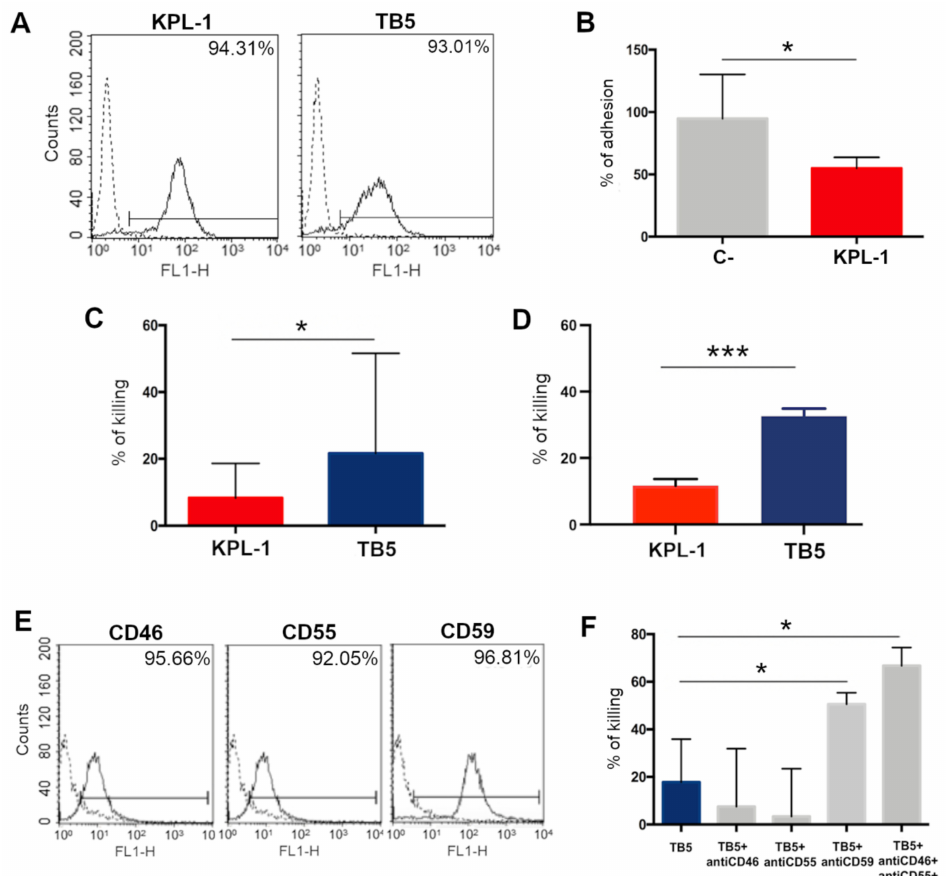
Figure 7. In vitro effect of anti-PSGL-1 antibodies on ALCL cell lines. ( A ) SU-DHL-1, a representative ALCL cell line, was analyzed by flow cytometry using two independent anti-PSGL-1 antibodies, KPL-1 and TB5, and a FITC-conjugated secondary antibody. ( B ) KPL-1 antibody was able to partially reduce SU-DHL-1 adhesion on EA.hy926 endothelial cell lines. ( C ) TB5 is able to induce direct cytotoxicity, analyzing residual cell viability after 48 h of incubation with SU-DHL-1 cells. ( D ) TB5, more than KPL-1, is able to induce ADCC of SU-DHL through PBMC activation and analyzing LDH release. ( E ) SU-DHL-1 cells evidenced the expression of CD46, CD55 and CD59 in FACS analysis after the incubation with specific antibodies and FITC-labeled secondary antibodies. ( F ) The binding of TB5 on the surface of ALCL cells is effective in inducing low levels of complement-dependent cytotoxicity using human serum as the source of complement. The percentage of lysed cells through CDC rises to significant values following blockage of the membrane complement regulatory proteins CD46, CD55 and CD59 expressed on SU-DHL-1 cells. p -values: * ≤ 0.05; *** ≤